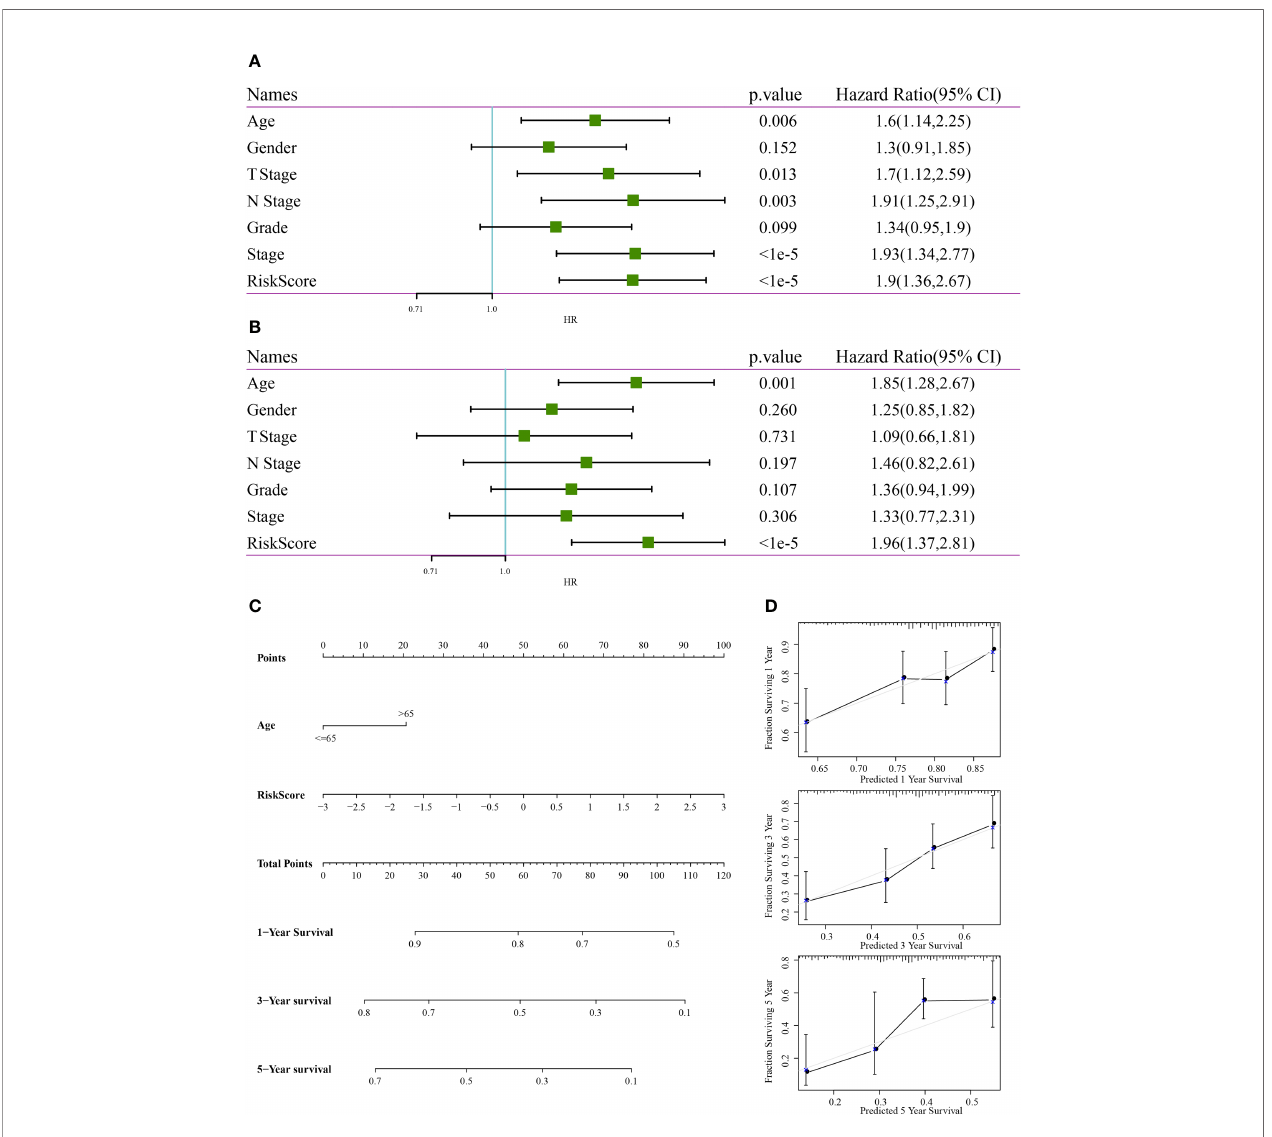
FIGURE 13 | Construction of a nomogram. (A) Results of univariate analysis between clinical features and RiskScore. (B) Results of multivariate analysis between clinical features and RiskScore. (C) Nomogram constructed based on clinical features and RiskScore. (D) Calibration curve of the nomogram for predicting survival